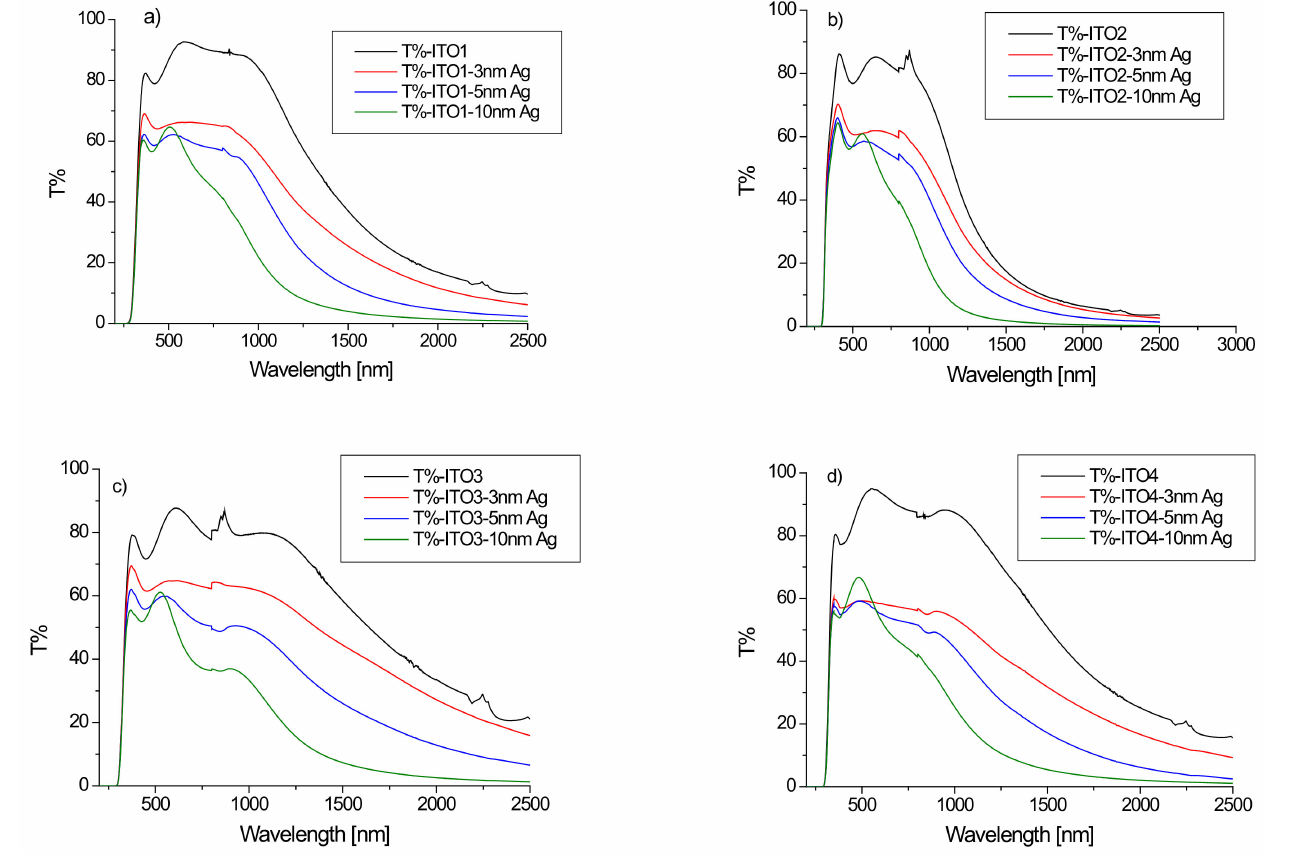
Figure 1. ( a – d ) Transmission spectra of ITO/glass substrates and Ag/ITO/glass structures for different ITO layers (( a )-ITO1, ( b )-ITO2, ( c )-ITO3, ( d